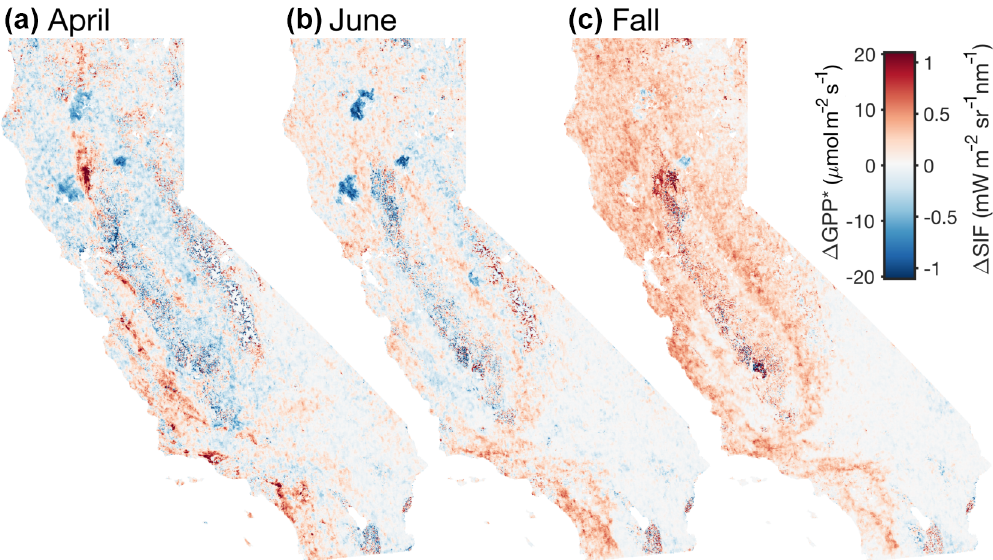
Figure 8. Difference between 2019 and 2018. Panel (a) shows the difference between the mean SIF in April 2019 and 2018. Panels (b) and (c) are the same as (a) but for June and fall (20 July–31 August), respectively. Red indicates higher SIF in 2019; blue indicates higher SIF in